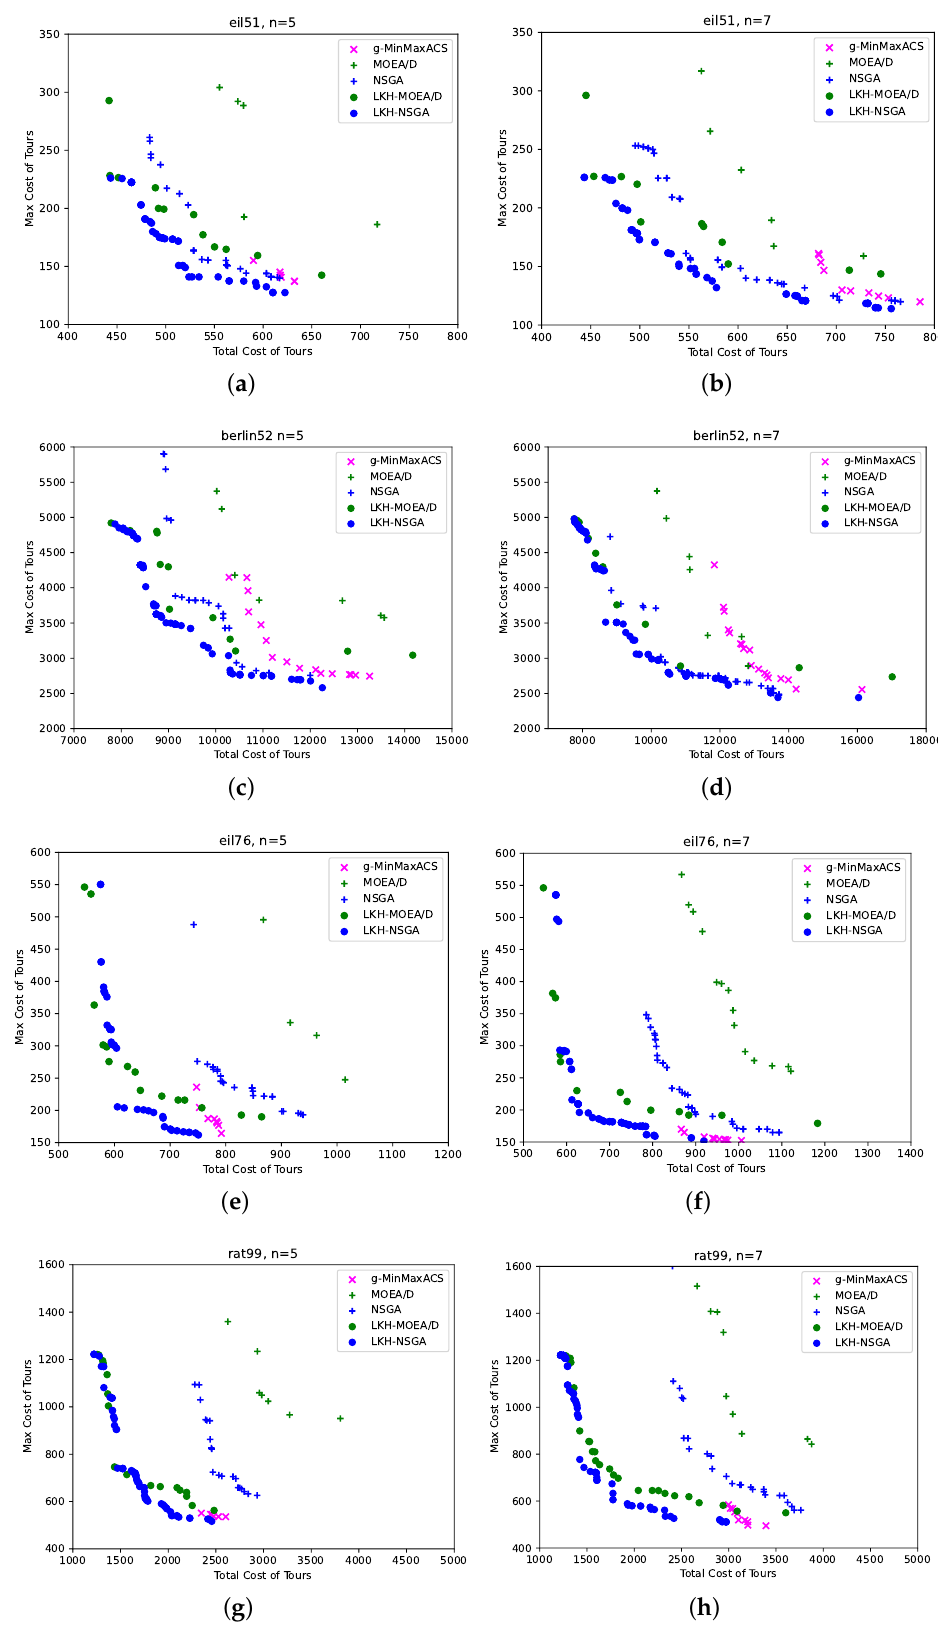
Figure 4. The resulting Pareto fronts of 5 different algorithms on 8 different